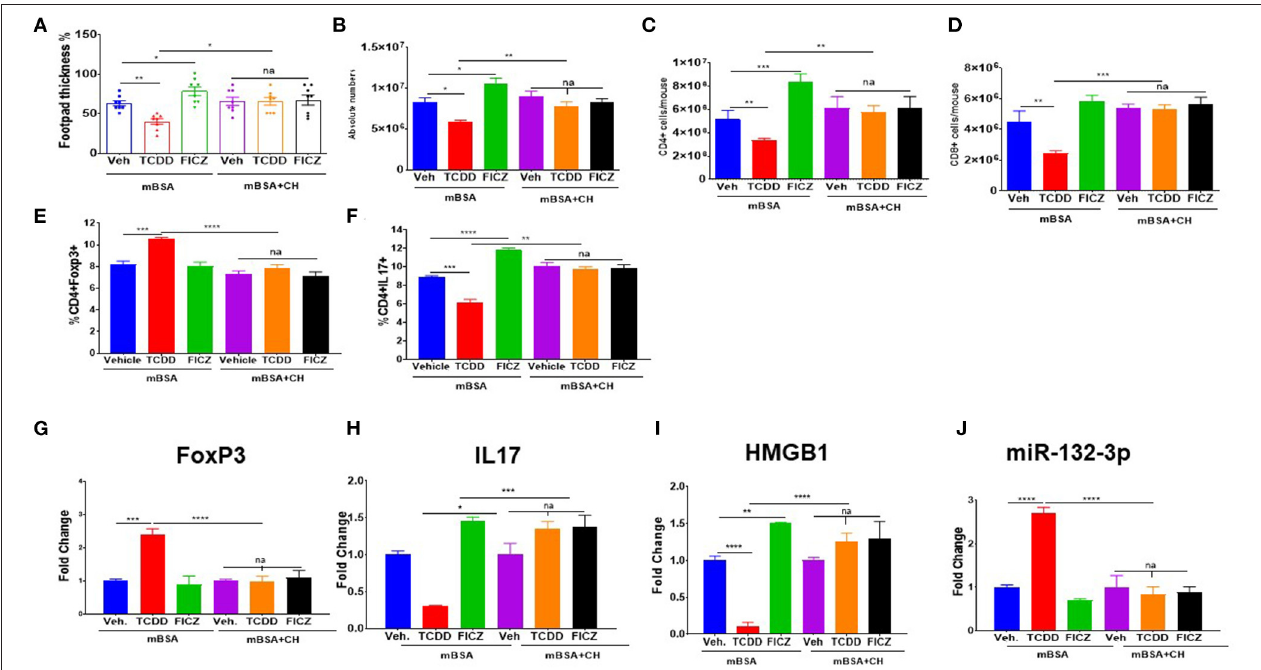
FIGURE 8 | Effect of AhR antagonist (CH) on TCDD and FICZ-mediated alterations in the DTH response. DTH was induced by injecting mBSA and these mice were treated with vehicle, TCDD or FICZ. Additionally, these mice received AhR antagonist (CH) prior to treatment with FICZ and TCDD. The draining DLN were harvested and studied as follows: (A) Showing the percentage change in footpad thickness. (B) Absolute cell number in DLN. (C) Absolute cell number of CD3 + CD4 + cells. (D) Absolute cell number of CD3 + CD8 + T cells. (E) Percentage of CD4 + FoxP3 + T cells. (F) Percentage of CD4 + IL-17 + T cells. qTR- PCR-based expression of Foxp3 (G) , IL17 (H) , HMGB1 (I) , and miR-132-3p (J) in DLN cells. Vertical Bars represent Mean ± SEM using groups of 5 mice and significant differences between groups are shown with asterisks (* p < 0.05, ** p < 0.01, *** p < 0.001, **** p < 0.0001) based on one-way